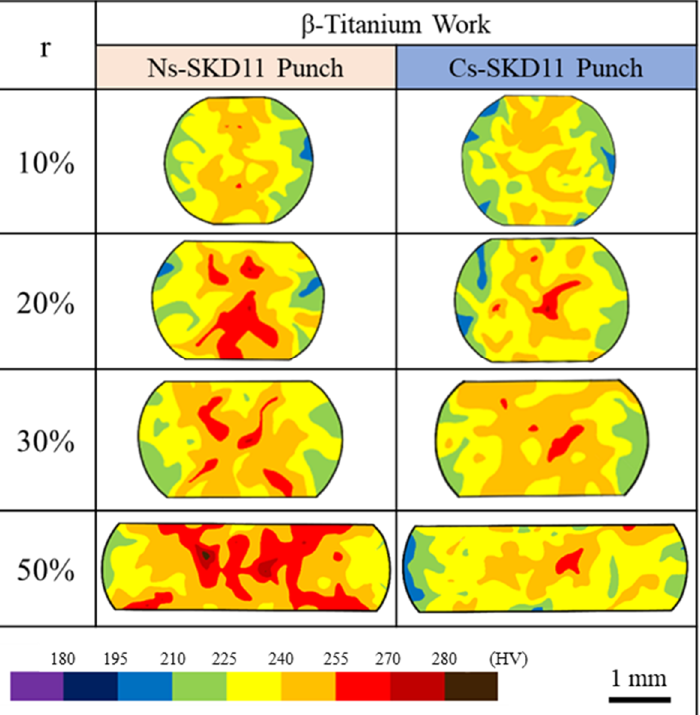
Figure 11. Variation of the work-hardening behavior during the forging process of the β-titanium alloy wires between the Ns-SKD11 and Cs-SKD11 punches.